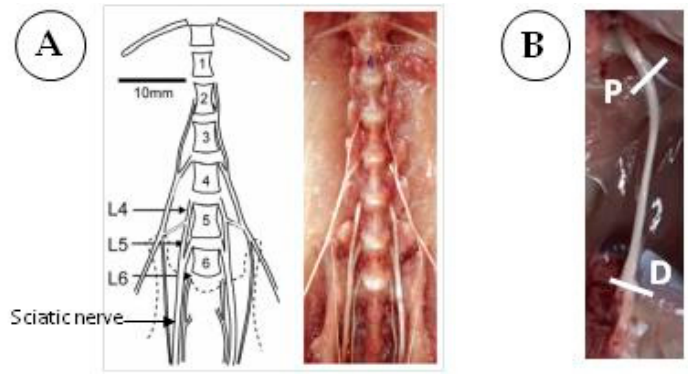
Figure 1. Dissection of rat sciatic nerves. ( A ) Ventral view of dissection and reference drawing made from it, showing the segmental origins of sciatic nerve from Sprague Dawley strain (figure taken from Rigaud et al. [30] with permission); ( B ) Sciatic nerve from a male Lewis rat aged nine weeks showing removal sites of the proximal (P) and distal (D) segments.